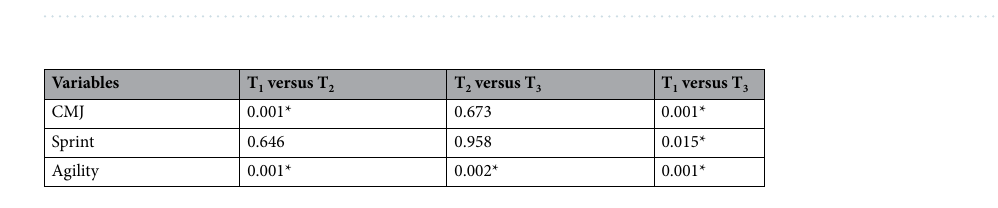
Table 3. Post hoc pairwise comparison with time. N = 24; CMJ Countermovement Jump, T 1 at baseline, T 2 at 4-min, T 3 at 12-min. *Significant difference at p < 0.01.